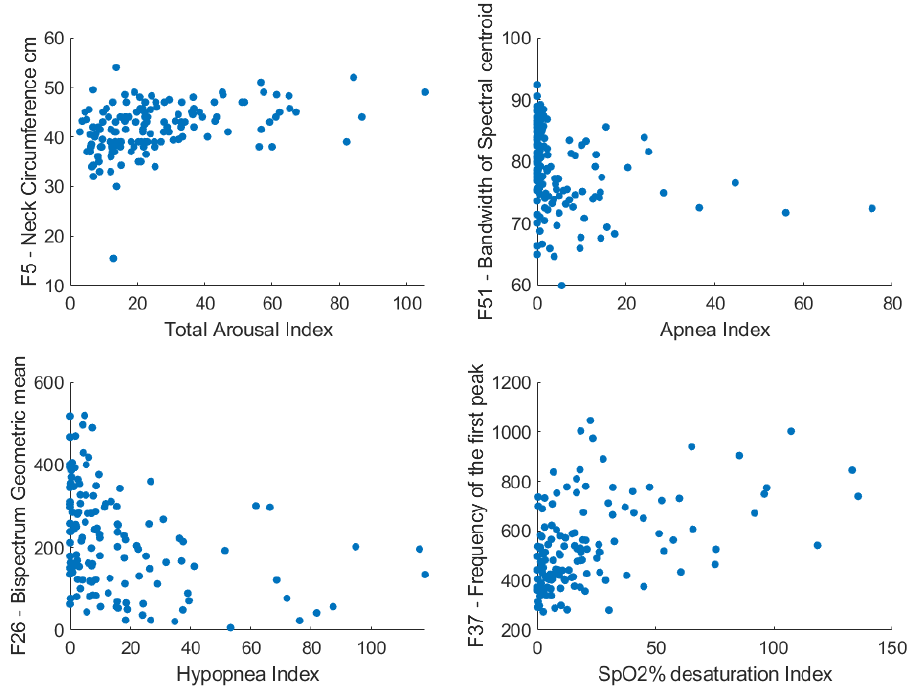
Figure 4. The scatter plots between four PSG parameters and the anthropometric and sound features with the highest correlation coefficients with them. F: feature label.